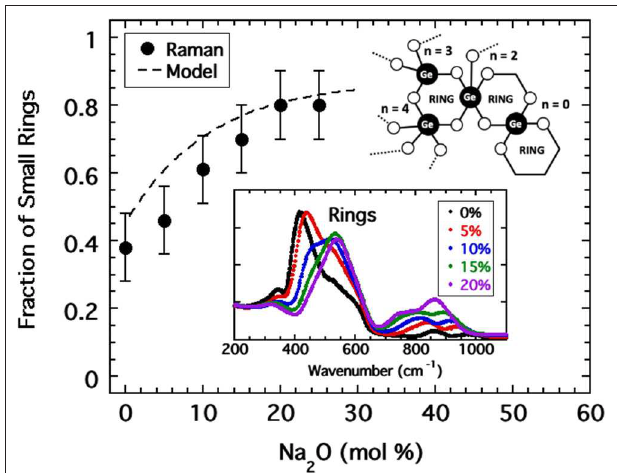
FIGURE 8 | A curve fitting analysis of the low energy Raman band (shown as inset) of sodium germanate glasses ( Henderson and Fleet, 1991) provided an estimate of the fraction of this band which is associated with 3-membered rings plotted as solid circles. The dashed line is the corresponding fraction of rings modeled as a continuous function of sodium oxide content by Equation (5) for which parameters were adjusted to best produce a collapse of fragility indices in Figure 9 . Inset includes a cartoon illustration of various possible RSUs that occur as a consequence of 3-membered rings.